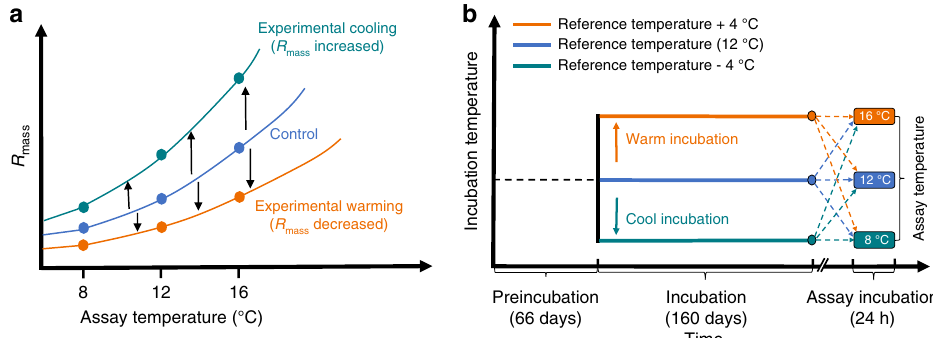
Fig. 1 Compensatory thermal responses of respiration and the experimental design used to evaluate the responses of soil microbial CH 4 respiration to experimental warming or cooling. a The patterns of microbial respiration that would be observed in the case of physiological compensatory responses. Respiration rates are expressed per unit of microbial biomass ( R mass ). b Our study design. The reference temperature was set at 12 °C to represent the mean growing-season temperature in the selected wetlands. The 66-day anaerobic preincubation period allowed for depletion of inorganic terminal electron acceptors (TEAs) and stabilization of the CH 4 respiration rate. On day 66 , three different thermal treatments (experimental warming and cooling and control conditions) were established. At the end of the incubation period, short-term assays were conducted at all three temperatures for each treatment to test for the compensatory response of microbial CH 4 respiration.